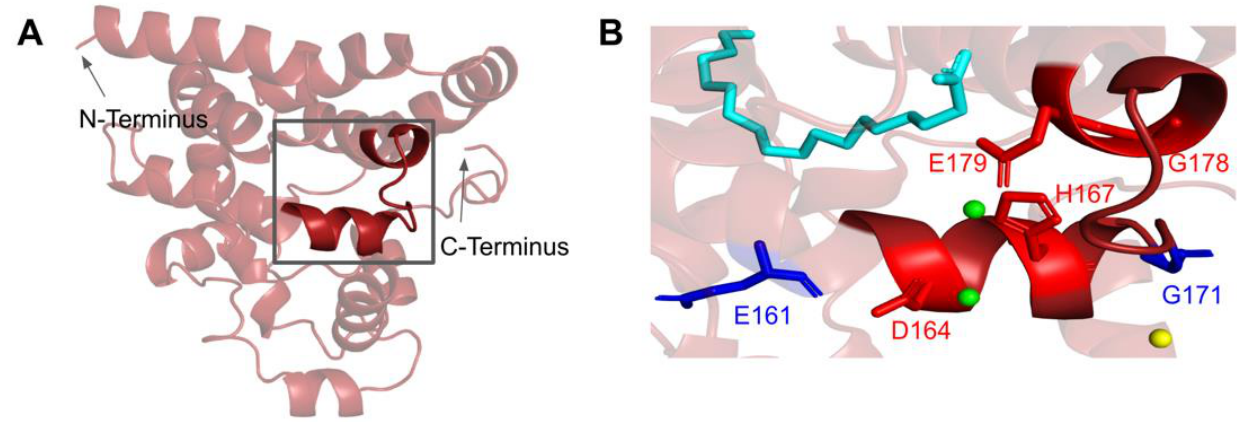
Figure 11. SNVs found in the putative COQ4 metal-liganding motif. ( A ) The metal-liganding motif (encompassing residues H163 to E179) is highlighted in red on the COQ4 model. ( B ) Locations of SNVs are depicted. Structural alignment of Alr8543 and COQ4 identifies the metal-liganding motifs in COQ4. Metal ions and oleic acid were obtained from this structural alignment. Residues are colored according to their corresponding SNVs in Figure 9. Mg 2+ ions are designated as green spheres and Cl − in yellow. Oleic acid is represented by the cyan structure.